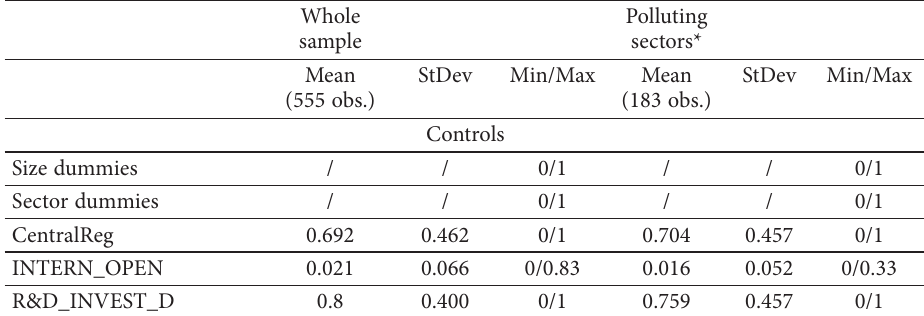
Table 2. Construction of the variables used in the analysis Energy/Material reduction per unit of product